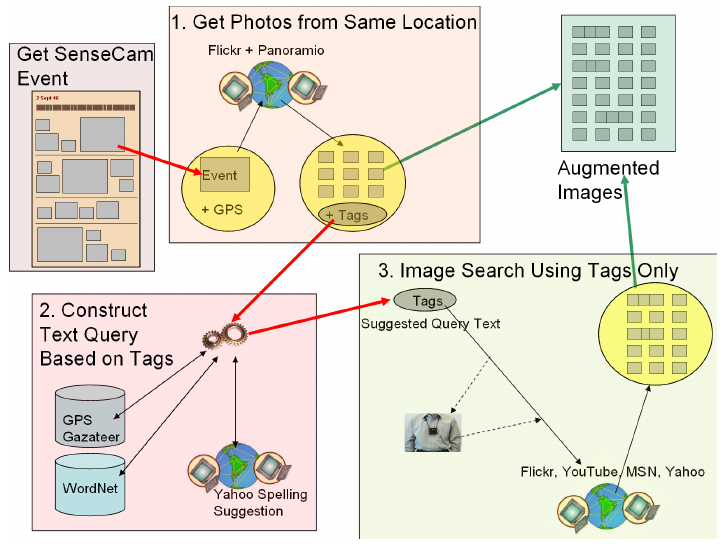
Figure 4. Overview of our Lifelog Event Augmentation